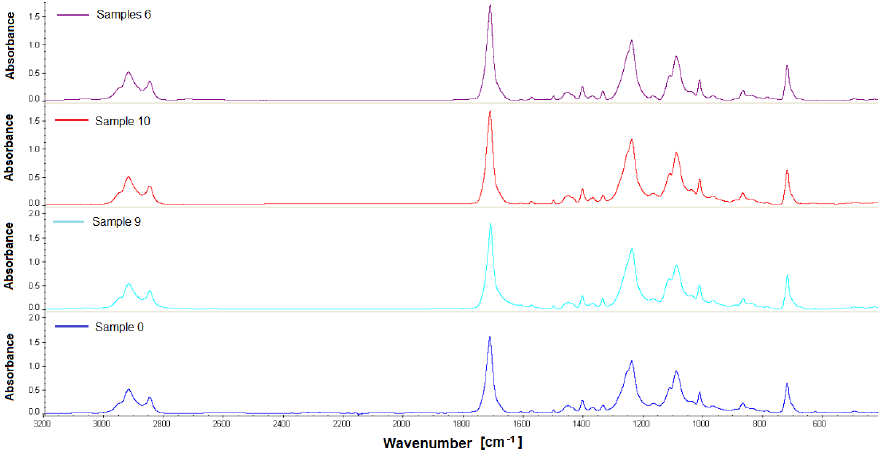
Figure 11. FTIR spectra of the studied PET-DLA 70 copolymers: sample 0-not implanted, sample 6, 9, 10 after 12-week implantation period.